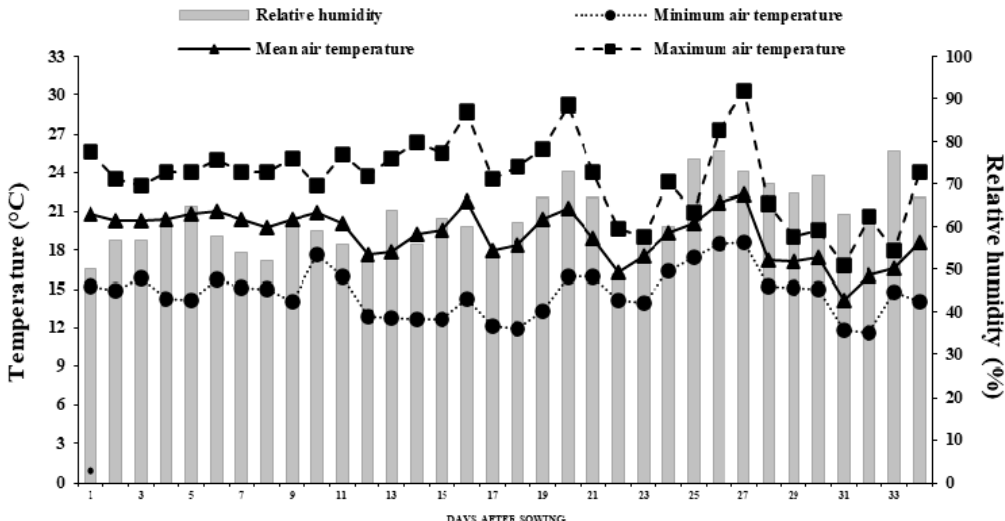
Figure 1. Microclimate conditions inside the greenhouse during the experiment at research station of University of Agriculture, Faisalabad, Punjab, Pakistan.